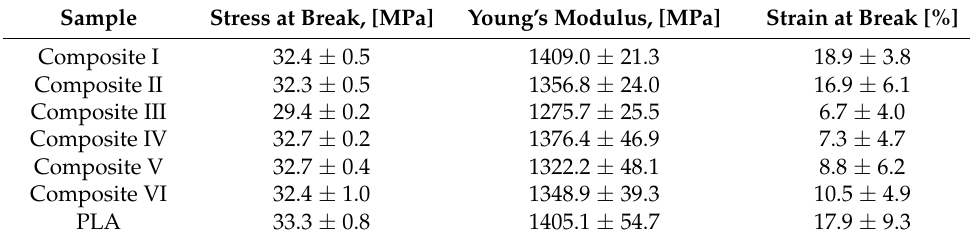
Table 8. Static tensile strength test results.